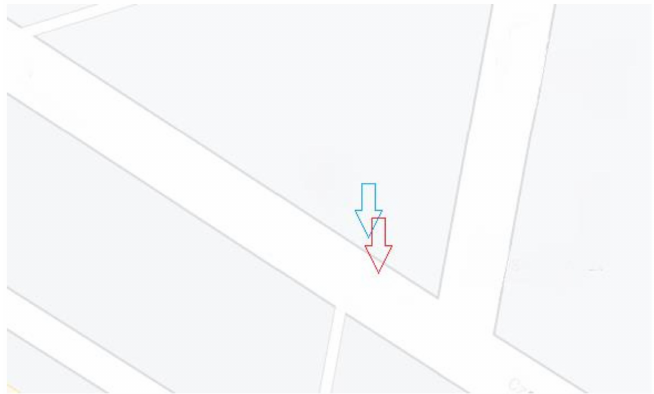
Figure 2. Sampling points: soil (blue arrow), road dust (red